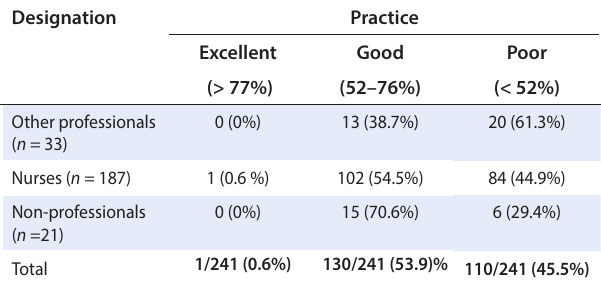
Table 5: Healthcare workers’ practices in dealing with healthcare